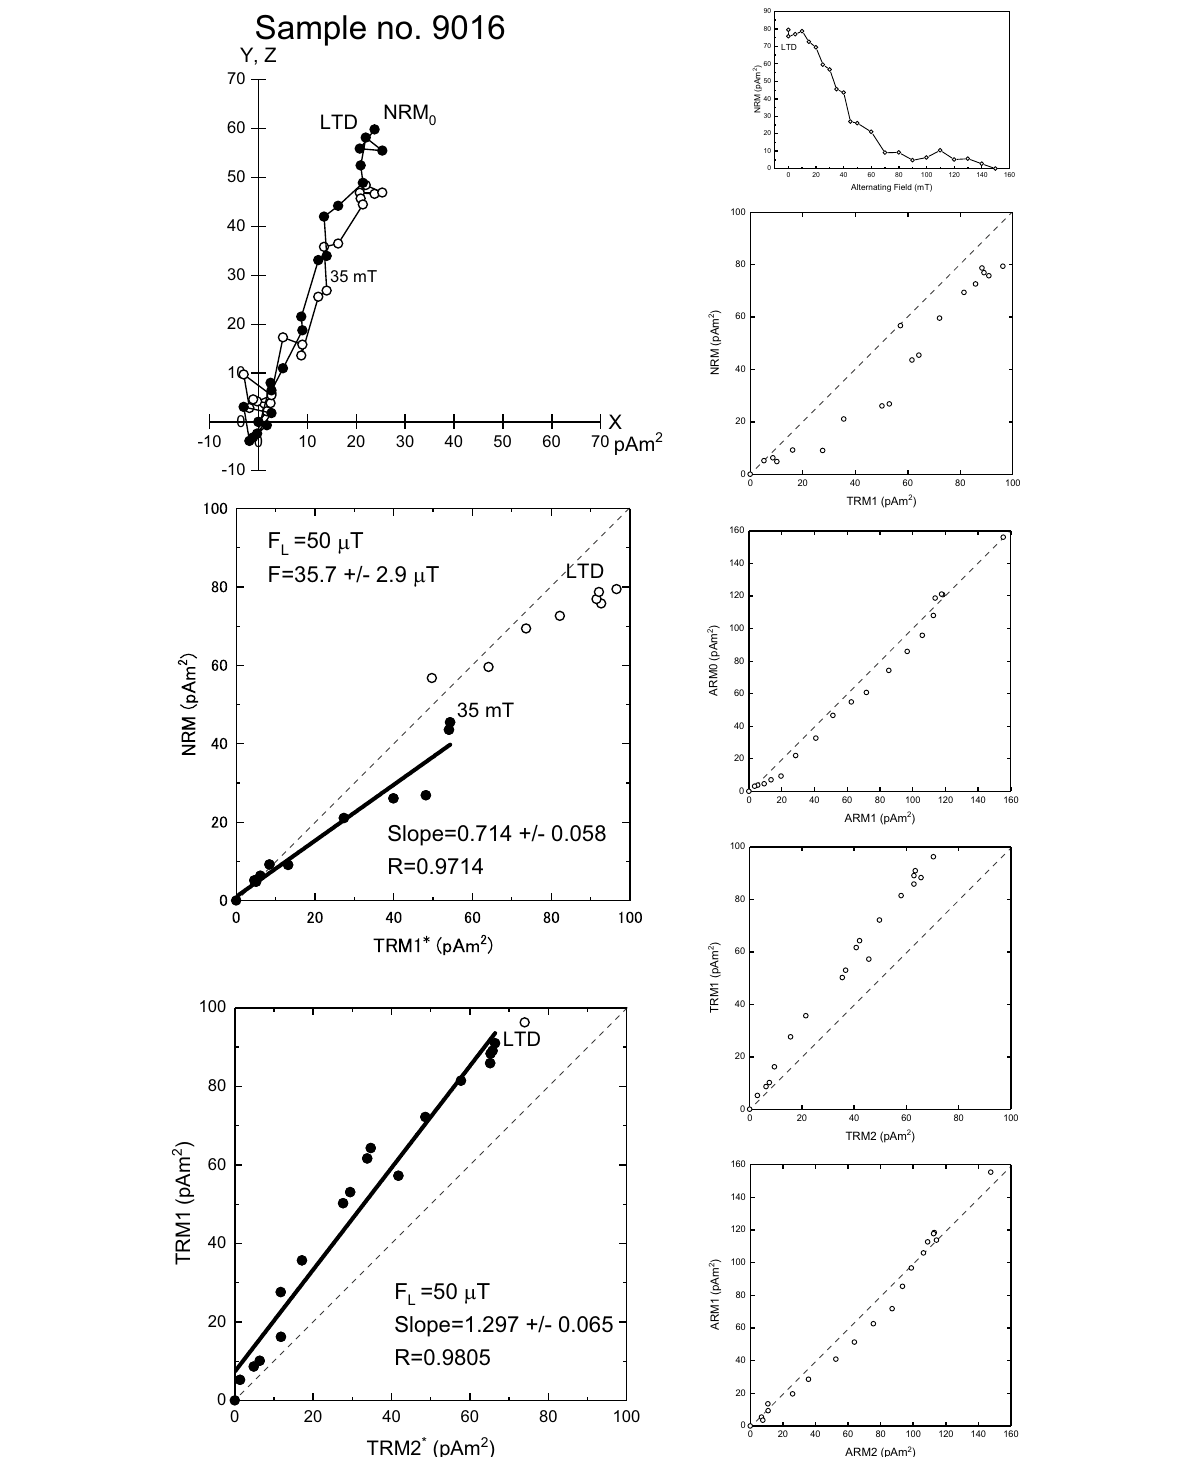
Fig. 9 Example of failed paleointensity measurements by the Tsunakawa–Shaw method on single plagioclase grain. In the orthogonal plot, open and closed circles indicate X – Y and X – Z planes, respectively. TRM1/TRM2* slope severely exceeds